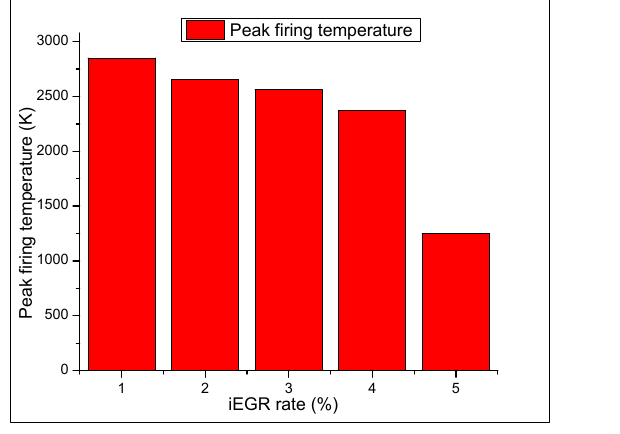
show that the peak firing temperature decreased from 2900 K to 1250 K, and the peak pressure rise decreased from 8 bar/deg to 5.5 bar/deg, respectively.